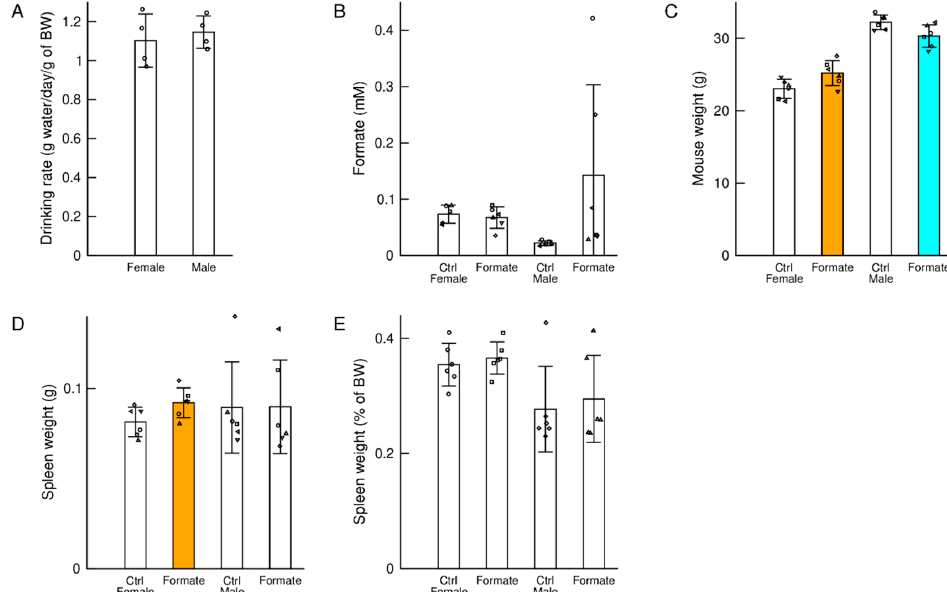
Figure 1. Major characteristics of the female and male cohorts drinking regular water (Ctrl) or water supplemented with 125 mM of sodium formate for 127 days, approximately 4 months. ( A ) Water drinking rate in the female and male cohorts of mice supplemented with sodium formate. ( B ) Plasma formate at the end of the study. ( C ) Body weight at the end of the study. ( D , E ) Spleen wet weight at the end of the study, in grams or as % of body weight (BW). Statistics: Each symbol shape represents an individual mouse, the bars heights represent the mean and the error bars the standard deviation. Coloured bars highlight a significant change ( p < 0.05) in the cohort with sodium formate supplementation relative to control of the same gender. Orange indicates a significant increase and cyan a significant